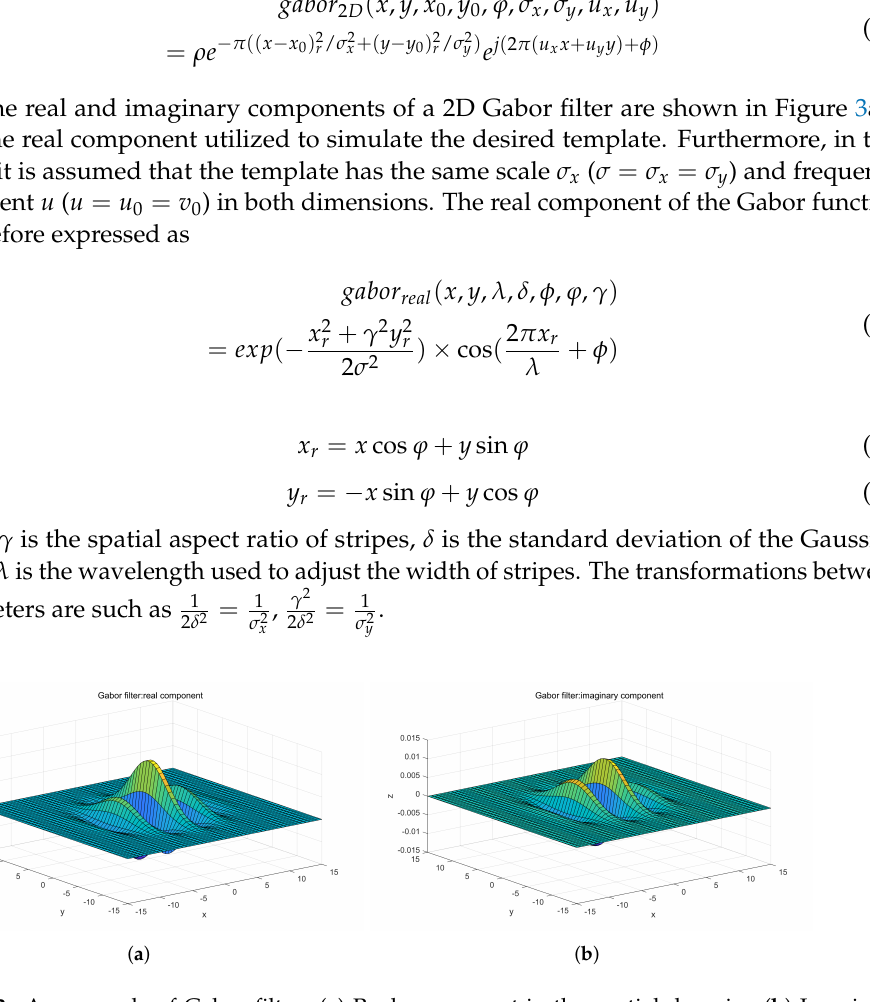
Figure 3. An example of Gabor filter. ( a ) Real component in the spatial domain. ( b ) Imaginary component in the spatial